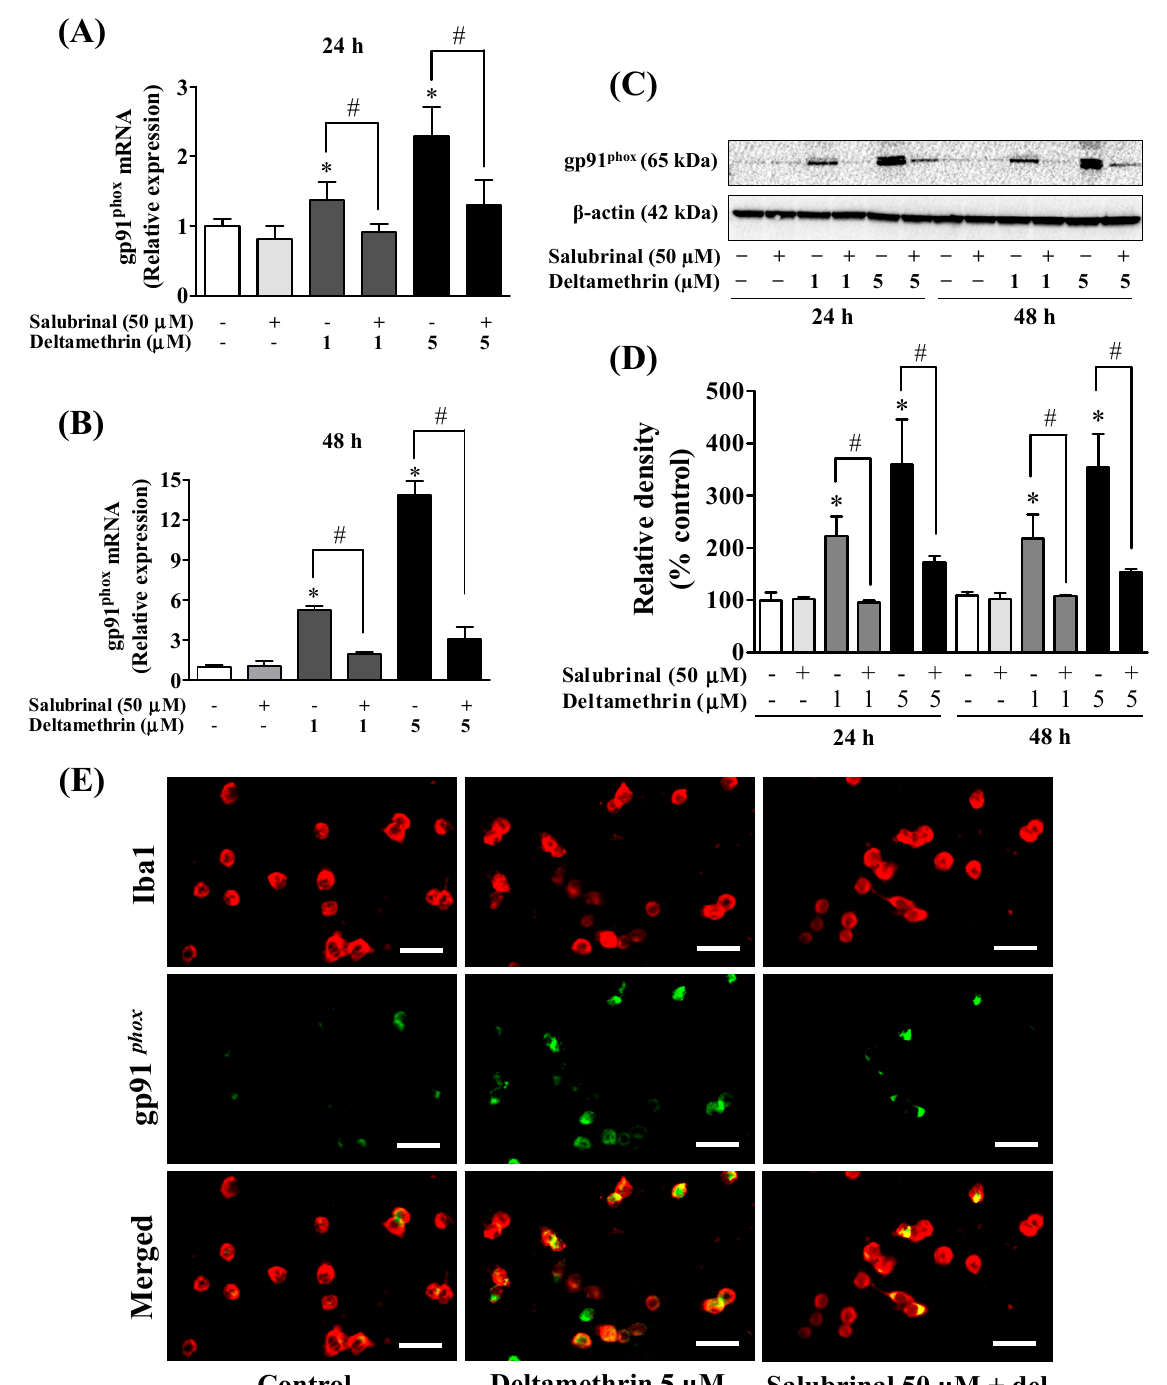
Figure 10. Inhibition of ER stress factor eIF2 α with salubrinal reduces deltamethrin-induced increased levels of gp91 phox in MMCs cells. ( A , B ) mRNA and ( C , D ) protein levels of gp91 phox . The protein bands were quantified by densitometry and the results reported as relative band densities. Since the membrane was stripped and re-probed with anti-gp91 phox after ATF-4, the same loading control is used from Figure 7. An asterisk denotes statistically significant difference from the control group, and a hashtag denotes statistically significant differences between deltamethrin and deltamethrin + salubrinal ( p < 0.05). ( E ) Expression of gp91 phox protein in MMCs was visualized by immunofluorescence staining. MMCs were labeled with anti-Iba1 antibody (red). Expression of gp91 phox protein was visualized by immunolabeling (green). Co-localization of gp91 phox and Iba1 is shown in yellow. Scale bar = 200 µm.